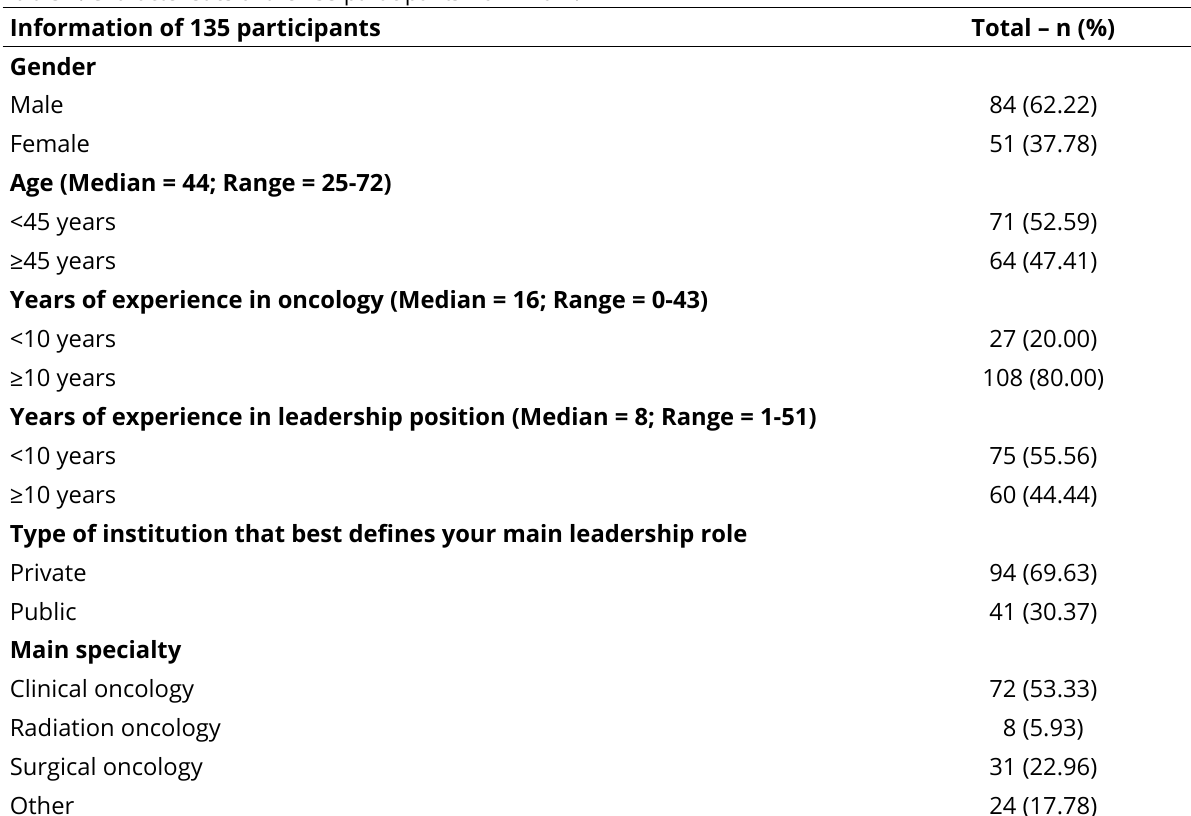
Table 1. Characteristics of the 135 participants from